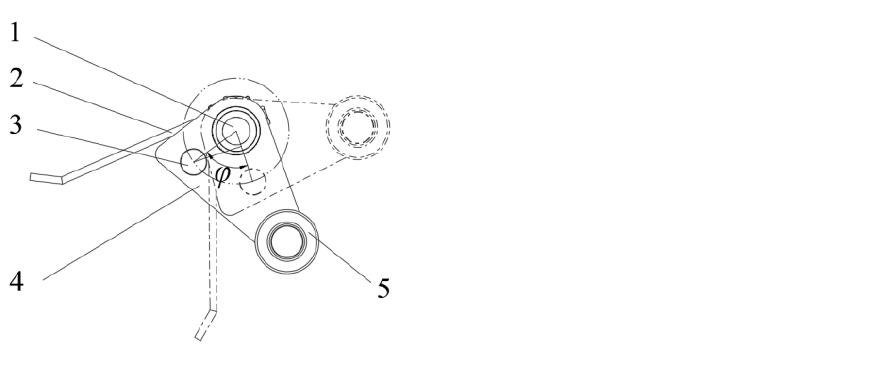
Figure 4. A schematic diagram of the rotation of the decapping area of the hook tooth assembly: 1. Hook tooth mounting shaft; 2. Hook tooth; 3. Short shaft; 4. Side guide plate; 5. Roller.